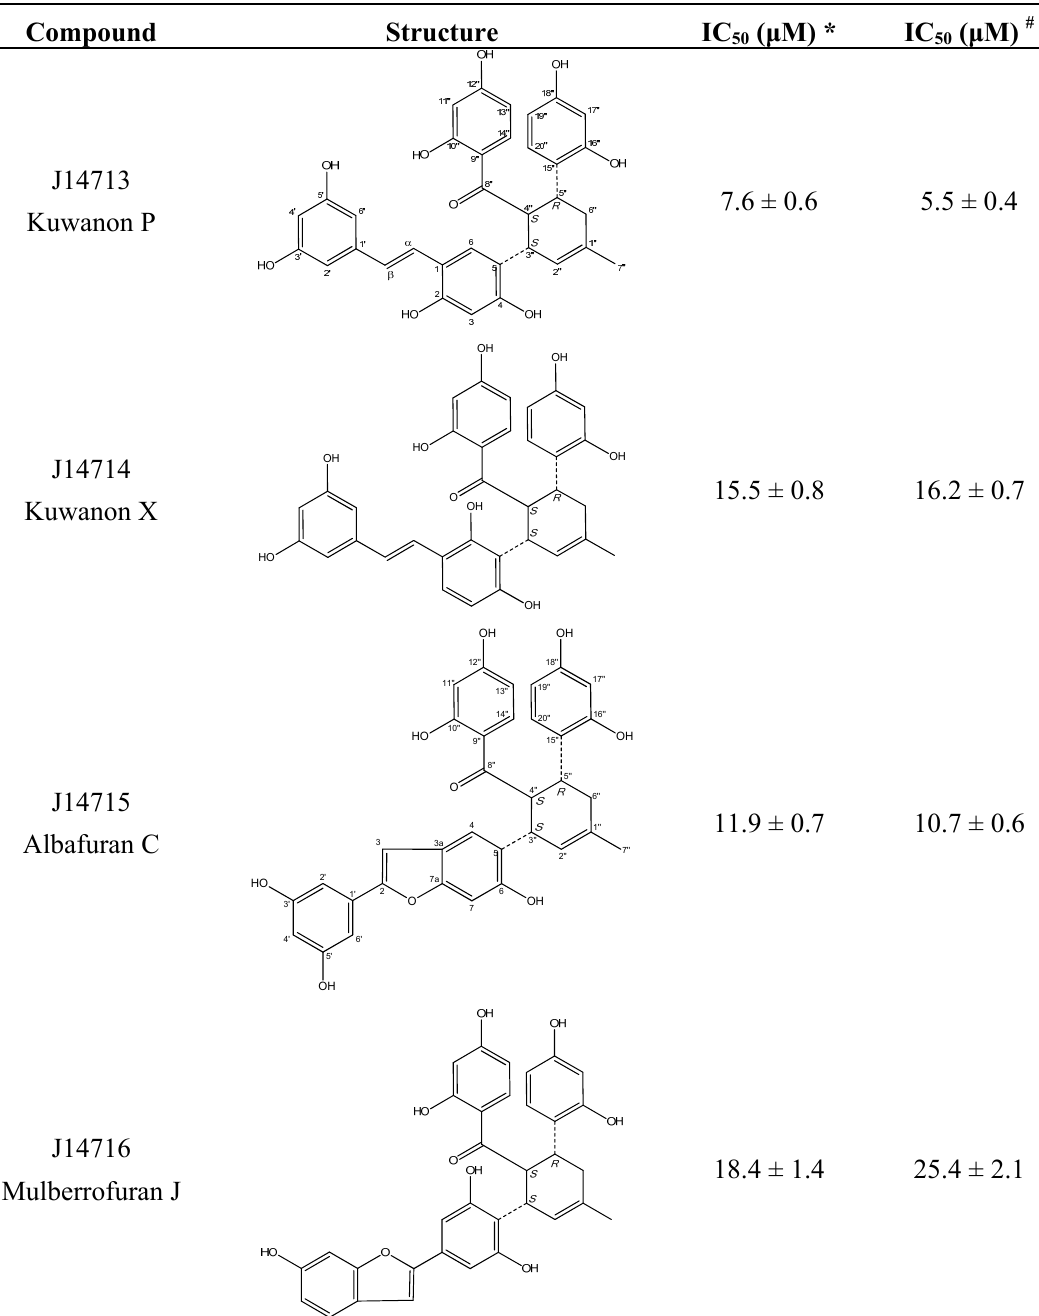
Table 1. Chemical structure and IC of three independent